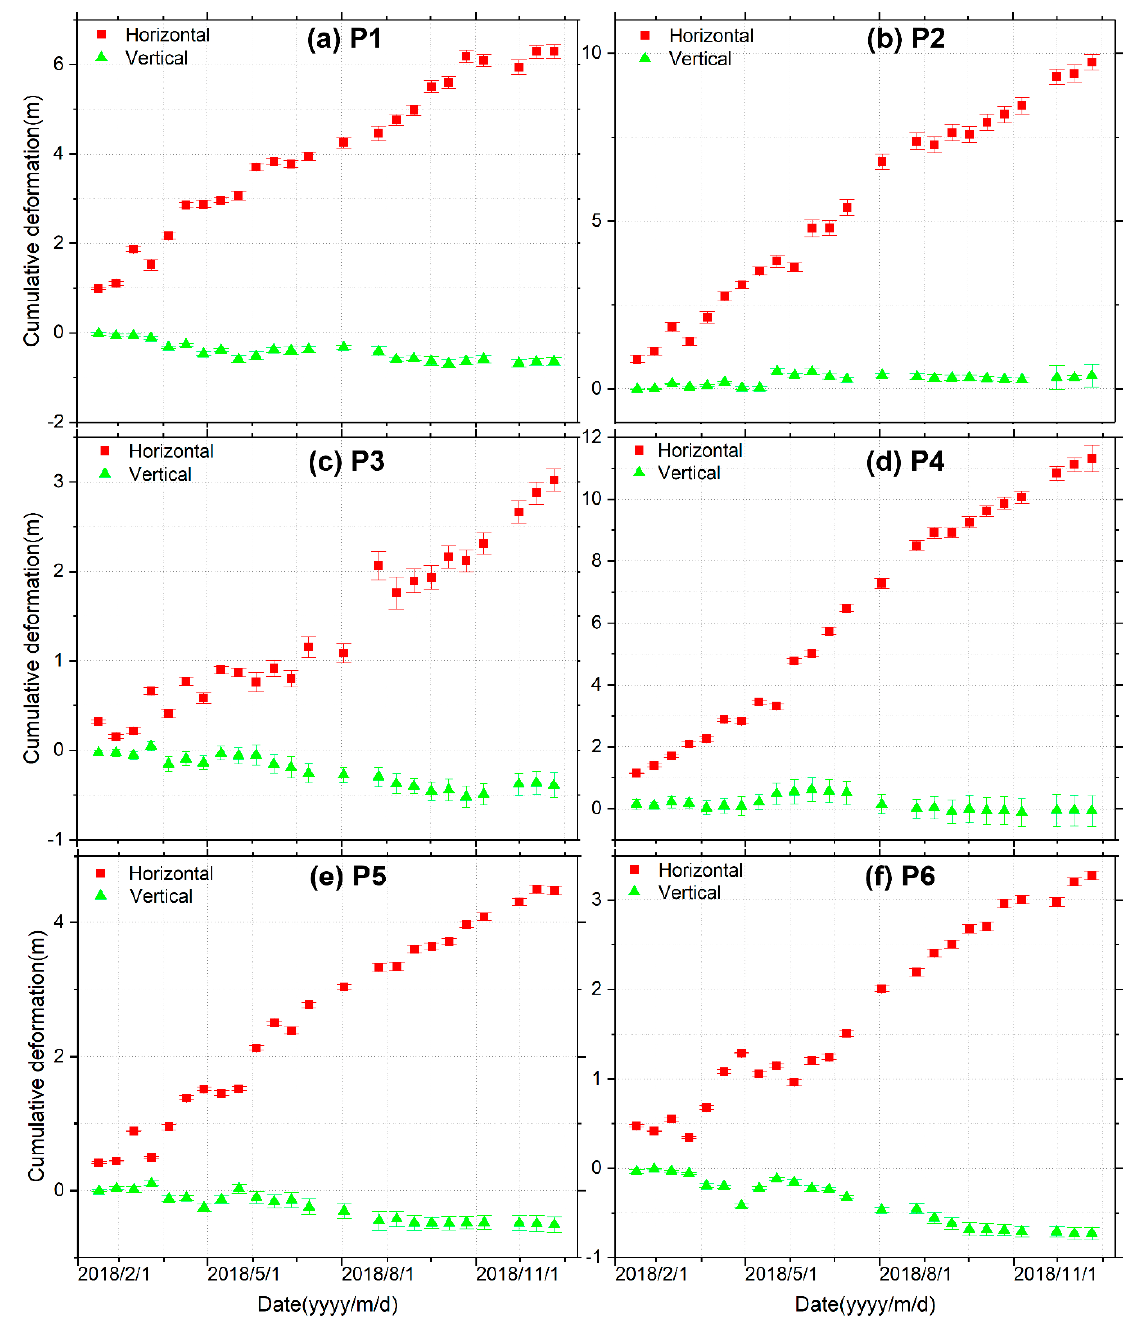
Figure 8. 3D deformation time series for points P1-P6. Red square and green triangle represent the horizontal and vertical time series movement, respectively. Locations of P1-P3 are shown on Figure 6a and P4-P6 are shown on Figure 7a. Negative values refer to downward movement. The red error bars indicated the STD of the average 3 × 3 pixels in horizontal directions and the green error bars indicated the errors for vertical direction. ( a )–( f ) represents the 3D time series displacement of points P1-P6, respectively.